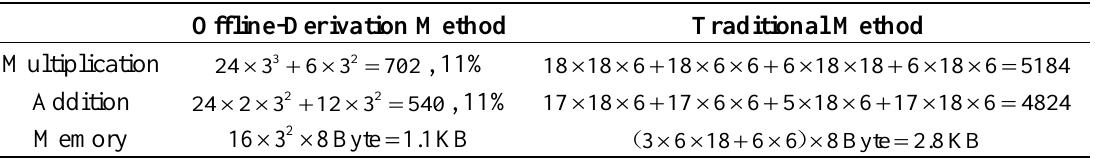
K updating process. n